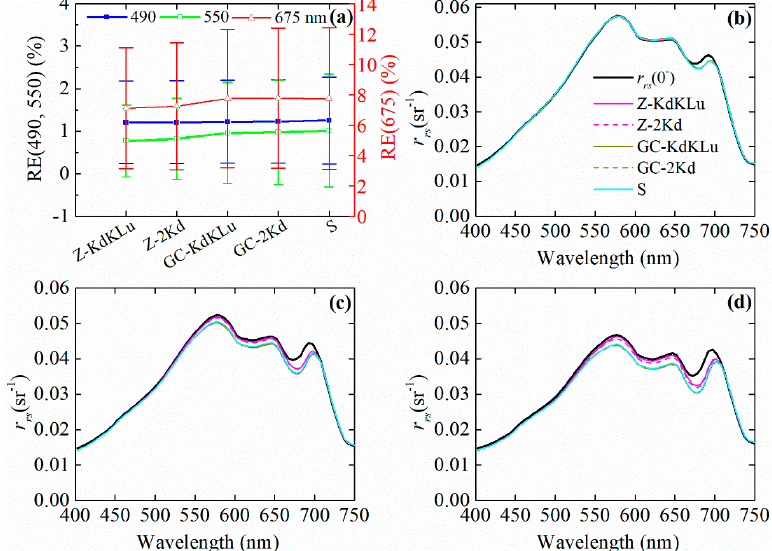
Figure 7. Performance of the five combinations of weighting average functions and K x . ( a ) Average relative error of all the simulated data at 490, 550, and 675 nm. Note that 490 nm and 550 nm use the left axis, and 675 nm uses the right axis. Weighting averaged r rs of ( b ) L1 (5, 16, 0.6), ( c ) L4 (10, 16, 0.2), and ( d ) L6 (10, 21, 0.2) derived by the five weighting average functions. “Z-KdKLu” represents the approach of Zaneveld et al. (2005) using K d + K Lu in the weighting average function, “Z-2Kd” represents the approach of Zaneveld et al. (2005) using 2K d , “GC-KdKLu” represents the approach of Gordon and Clark (1992) using K d + K Lu , “GC-2Kd” represents the approach of Gordon and Clark (1992) using 2K d , and “S” represents the approach of Sokoletsky and Yacobi (2011).